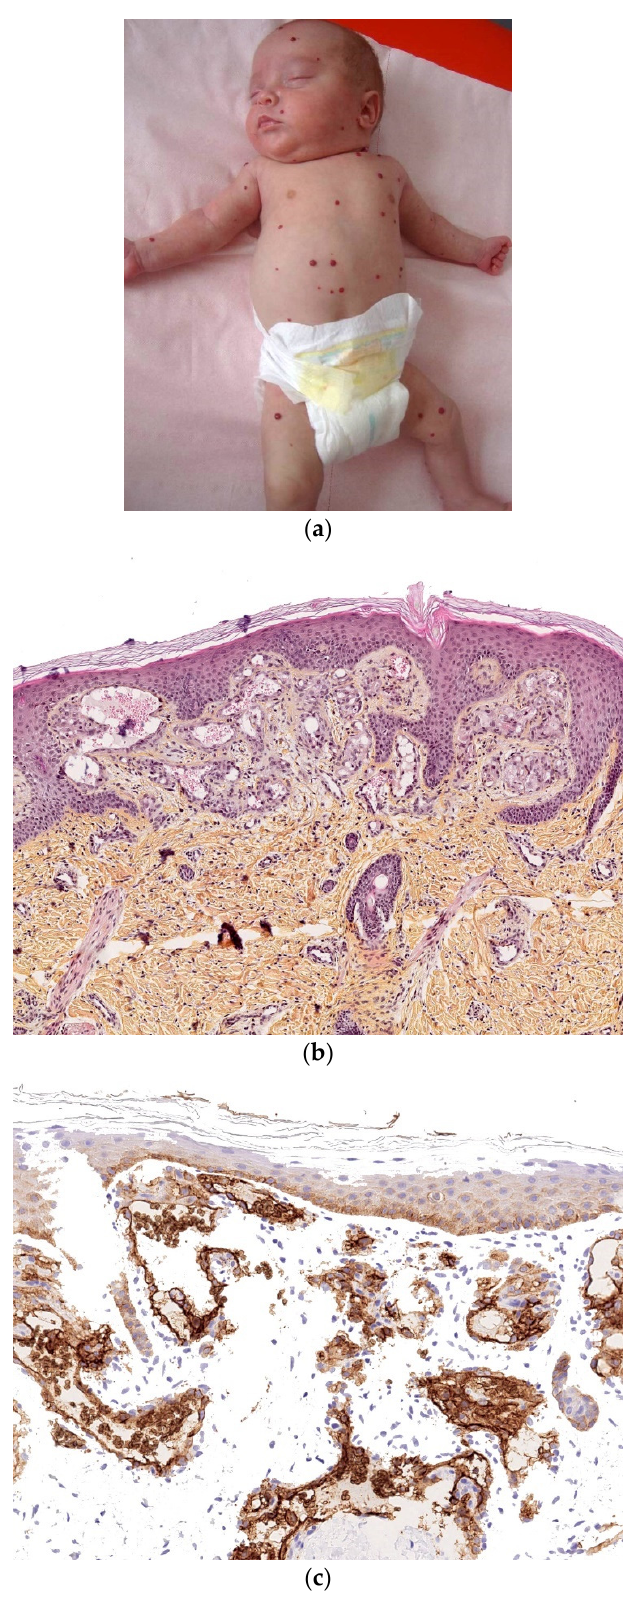
Figure 12. Multifocal infantile hemangioma. ( a ) Multiple small red lesions disseminated over the body. ( b ) 10 × Well-differentiated small vessels in the superficial dermis. ( c ) Anti-Glut1 immunostain- ing showing positivity of all the